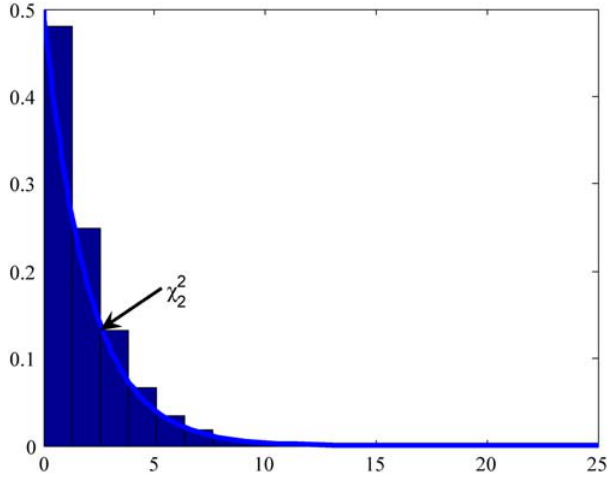
Figure 3. Null Distribution of the statistic T G and controls respectively.